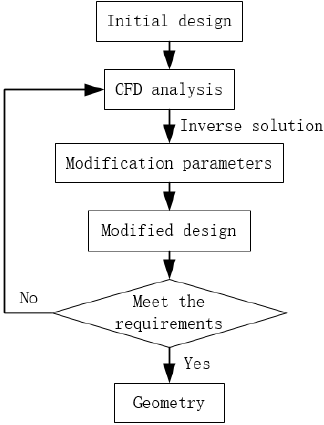
Figure 11. Design process of the efficient blade design method.